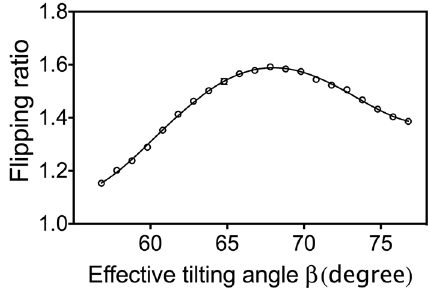
Figure 4. The flipping ratio of the fringes obtained at various effective tilting angles for the Si (111) diffraction plane (points) and its polynomial fit (solid